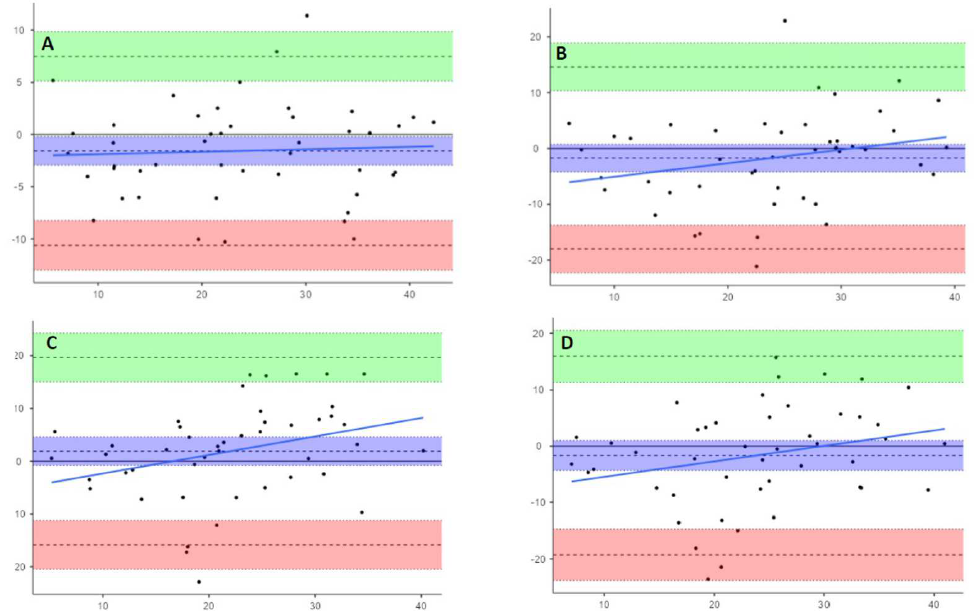
Figure 5. Bland–Altman plots showing paired difference between Venco classic and ( A ), Venco te-le;